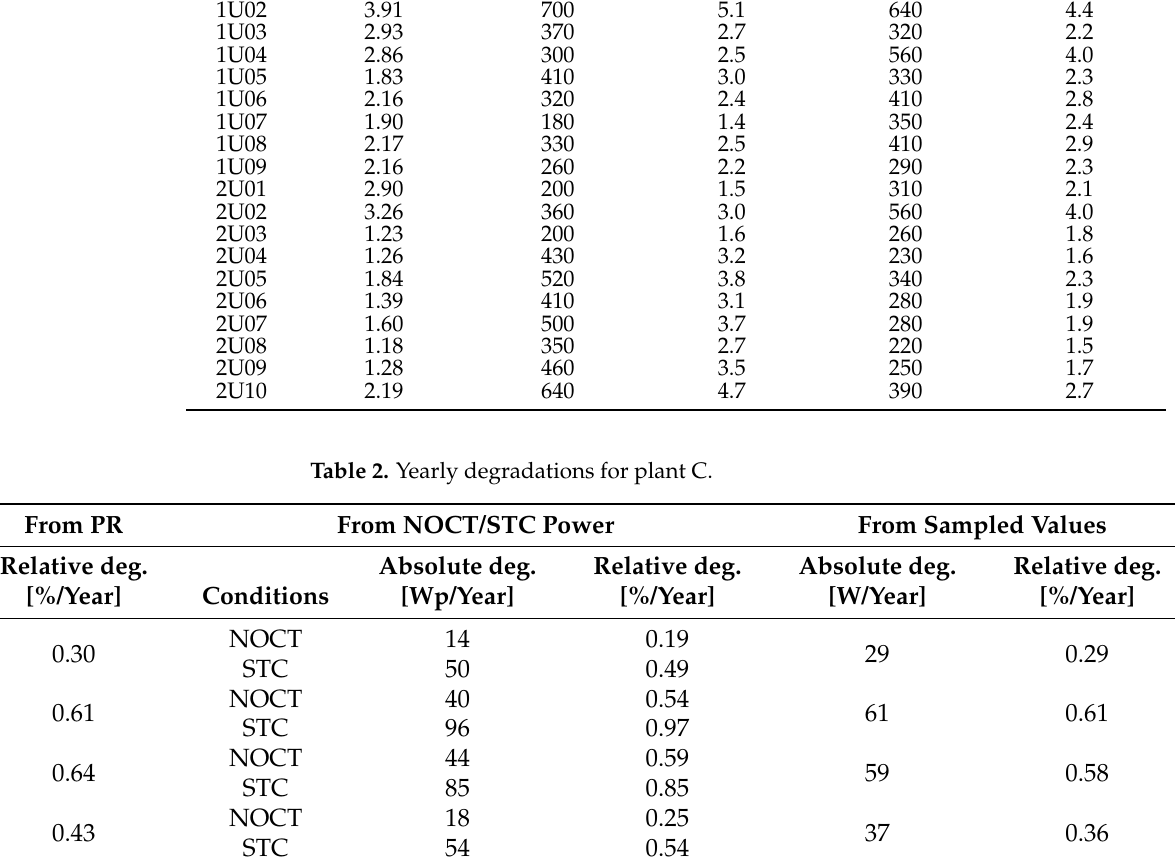
showing the degradation. In Figure 3c, the relative values in percentage are given for better clarity since the range of power values for inverters 97 and 98 is about 5 times higher than the one of the other inverters. For the other plots in Figure 3, the absolute values expressed in Watts are given. The yearly degradation of the DC power for all inverters in plant C is on average 50 W per year, or 0.5% per year. Plants A and B have higher degradation. More precisely, on average there is a yearly degradation of 1.9% for plant B and 2.5% for plant A. Table 1. Yearly degradations for plant plant A. From PR From NOCT Power From Sampled Values Relative deg. Absolute deg. Relative deg. Absolute deg.